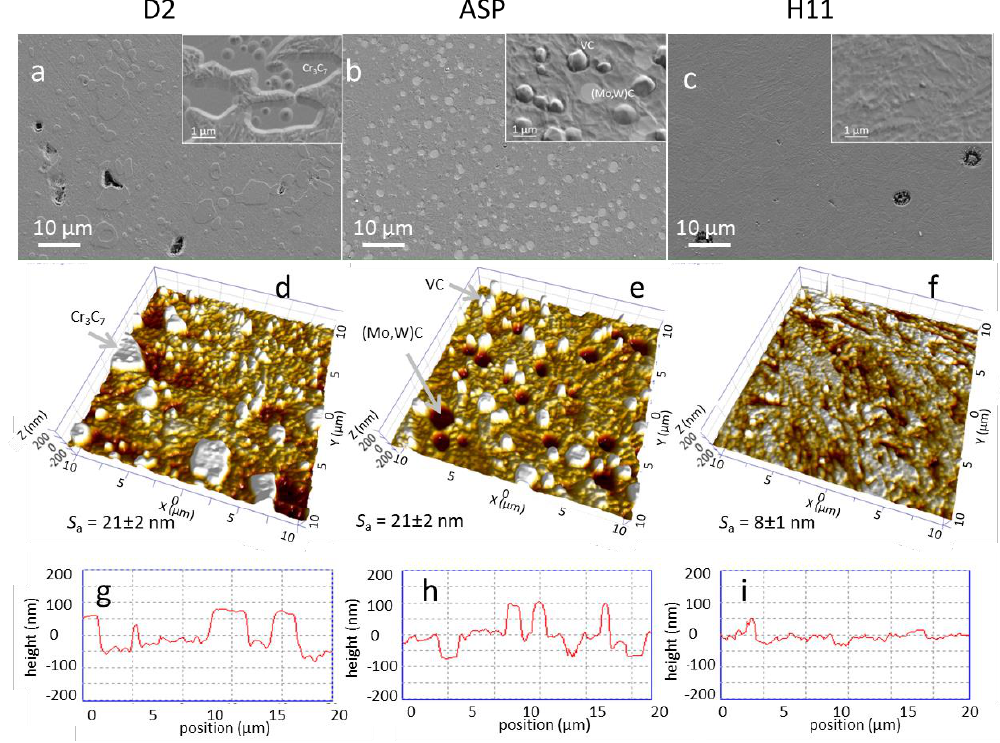
Figure 5. SEM images ( a – c ), AFM images ( d – f ), line profiles ( g – i ) and surface roughness (S a ) of D2, ASP30 and H11 tool steel substrates after RF ion etching in CC7 deposition system. The scan area and z-scale are 20 µm × 20 µm and 200 nm, respectively.